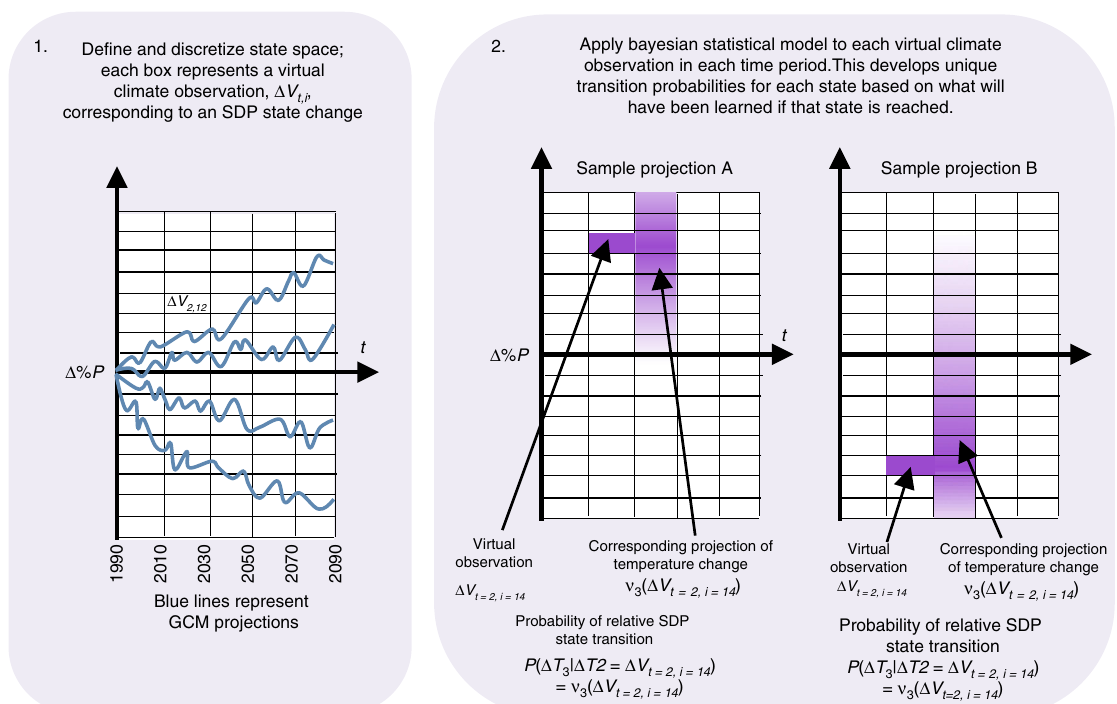
Fig. 1 Schematic of integrated modeling framework. a Full planning framework. b Detail on characterizing transition probabilities using Bayesian statistical model applied to each virtual climate